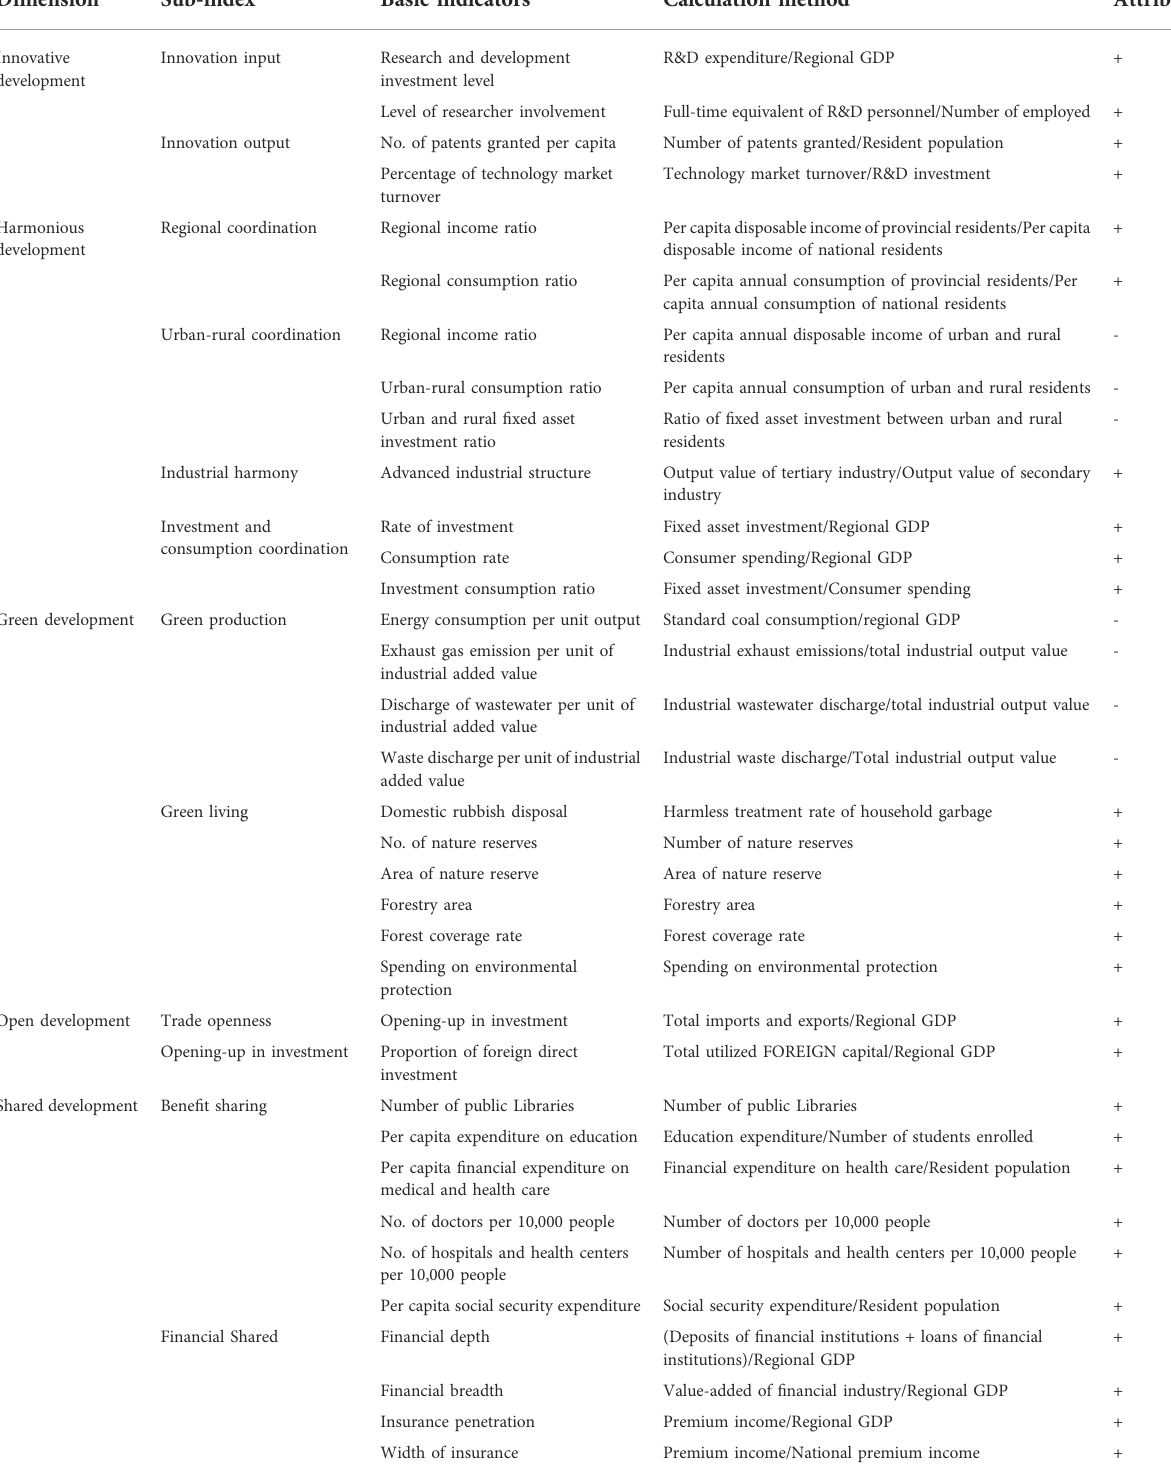
TABLE 1 Index system of high-quality economic